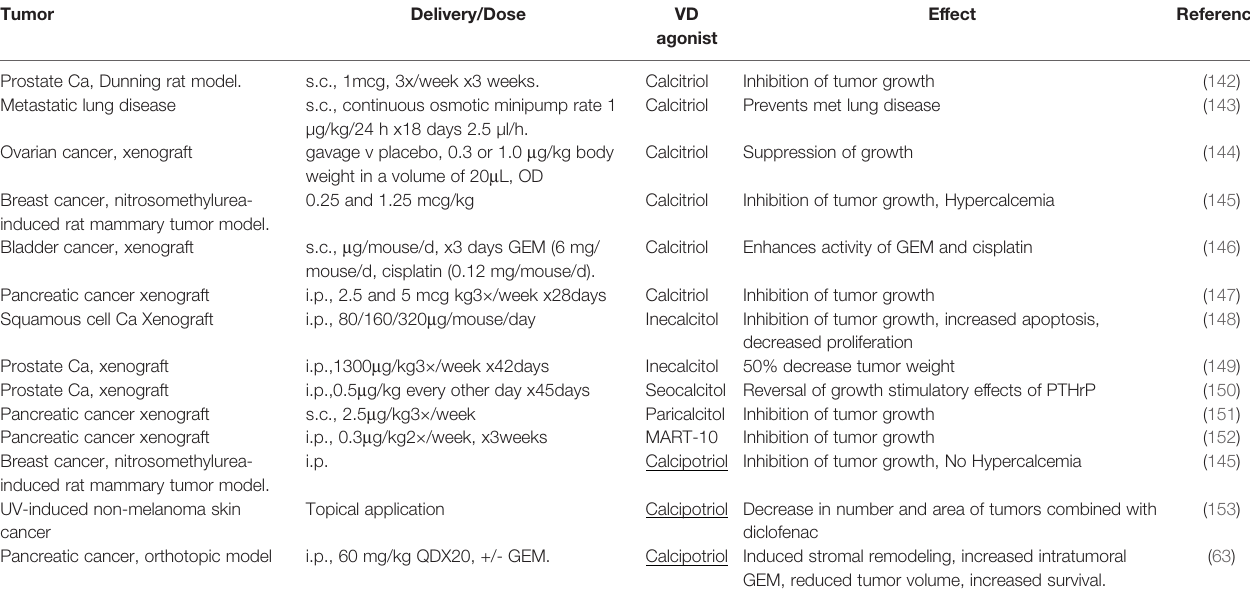
TABLE 3 | Preclinical studies of VDA (Vitamin D Analogues) in animal models of various cancer types. Tumor